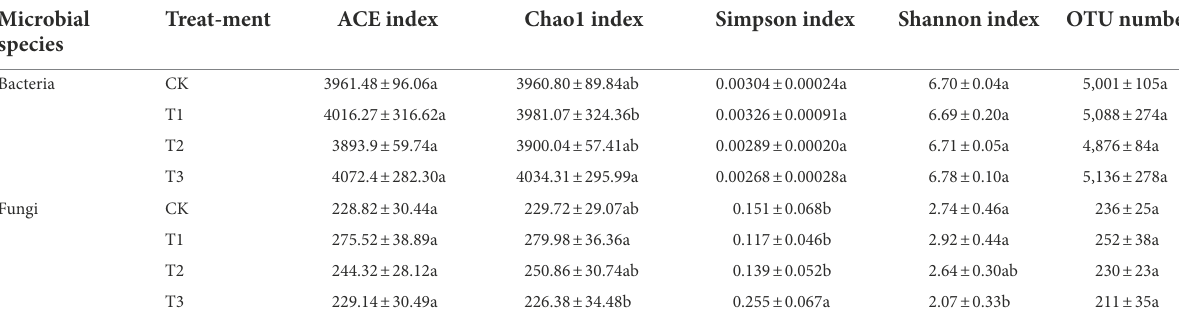
TABLE 4 Effects of different irrigation amounts on alpha diversity of bacteria and fungi in OTU level. Microbial